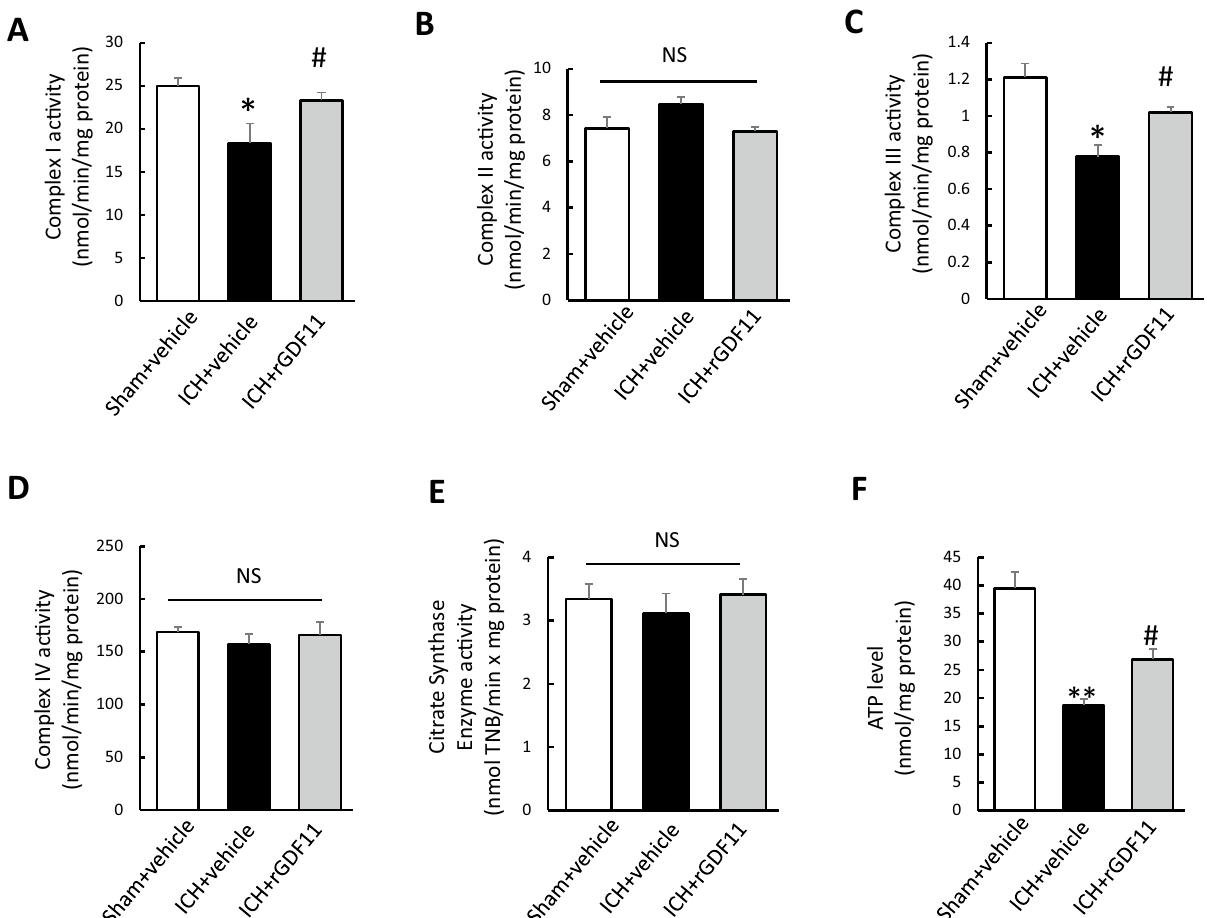
Figure 2. GDF11 restored mitochondrial dysfunction in brain tissue in elderly ICH rats. ( A – E ) Complex I, II, III, V and citrate synthase enzyme activities in the indicated groups on day 3 post-ICH. ( F ) ATP level reduction in indicated 3 groups. n = 6–8 animals per group. Values shown as mean ± SD. *p < 0.05 and **p < 0.01 versus sham + vehicle group; # p < 0.05 versus ICH + vehicle